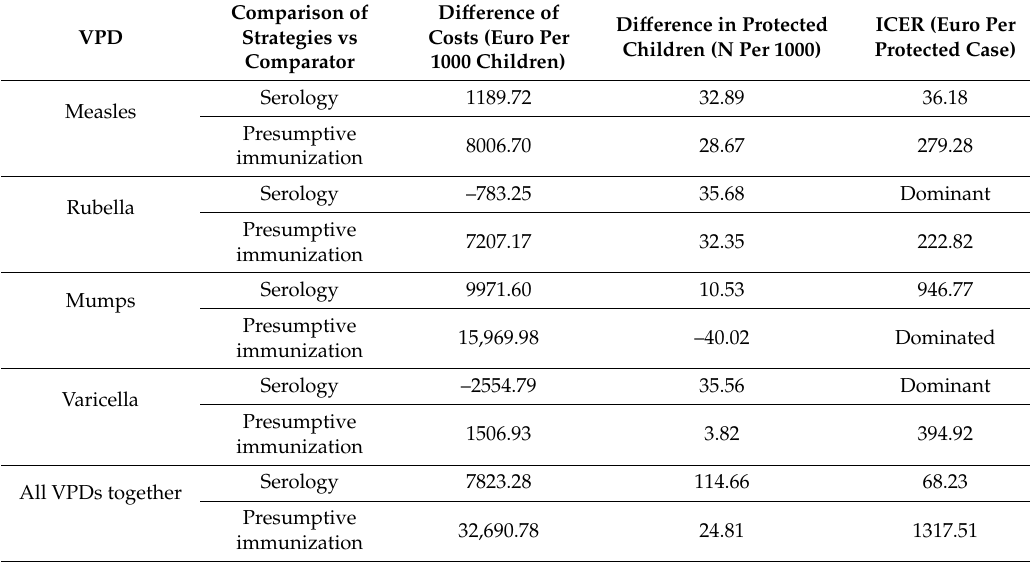
Table 8. Comparison of strategies according to disease (ELISA